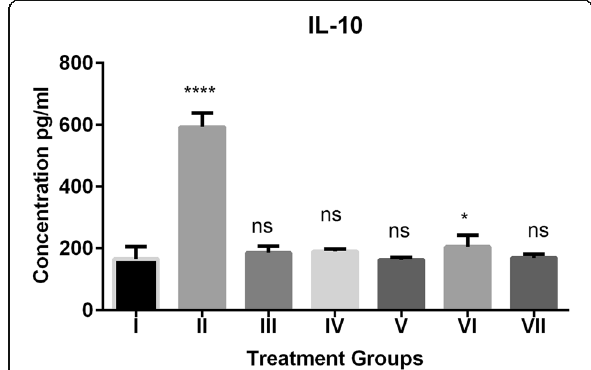
Fig. 4 Effect of grapefruit juice (GFJ) and aripiprazole (ARI) on oxidative stress induced by H 2 O 2 by IL-10 levels. IL-10 concentration is expressed as pg/ml (n = 10); The treated groups were compared to control group. **** P < 0.0001, * P < 0.1, ns: non-significant. # Group I: Control; Group II: H2O2 treated; Group III; ARI treated; Group IV GFJ treated; Group V: GFJ and H 2 O 2 treated; Group VI; ARI and H 2 O 2 treated; Group VII; ARI, GFJ and H 2 O 2 treated